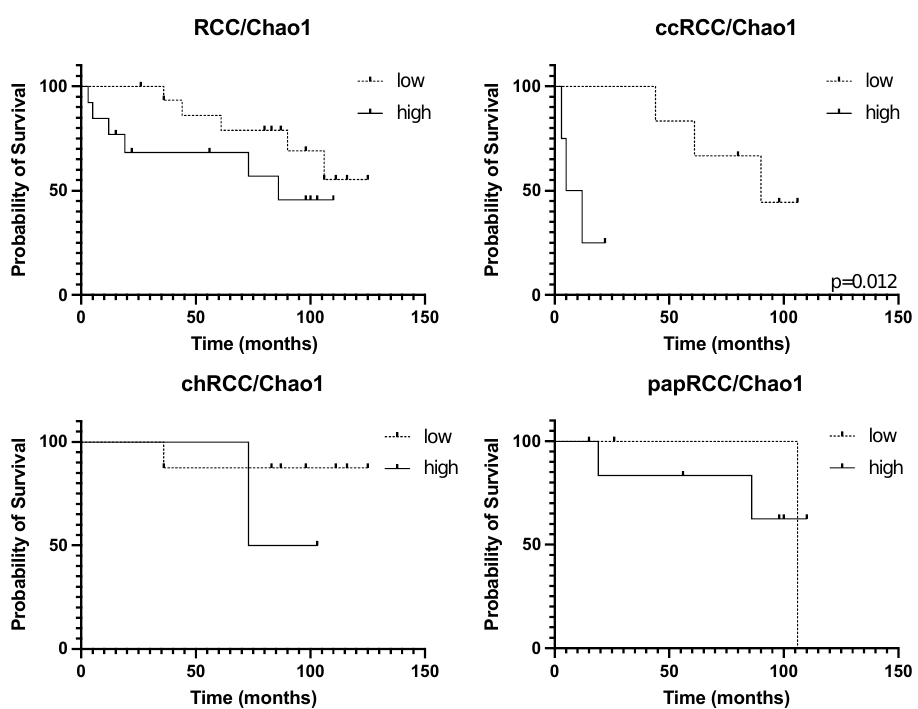
Figure 8. Prognostic significance of taxonomic diversity for RCC of different histotypes.